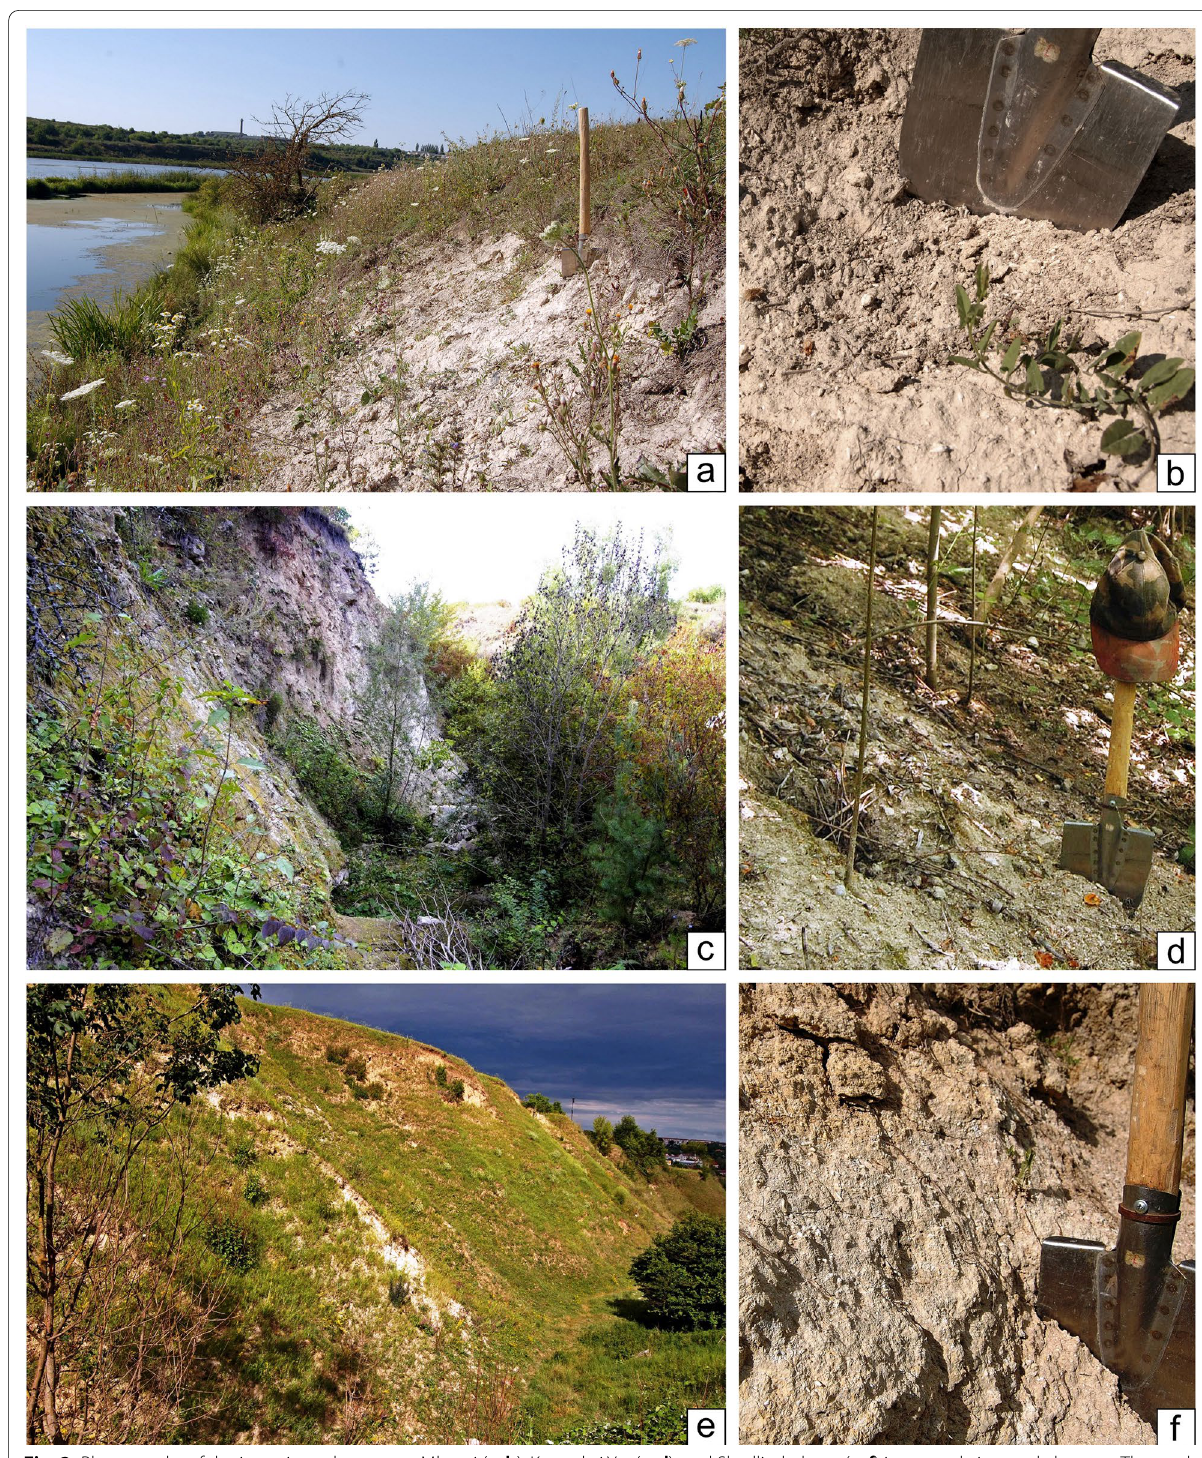
Fig. 2 Photographs of the investigated outcrops: Mlyntsi ( a , b ), Kozatskyi Yar ( c , d ), and Shydlivshchyna ( e , f ) in general view and close-up. The total length of the shovel handle is 72